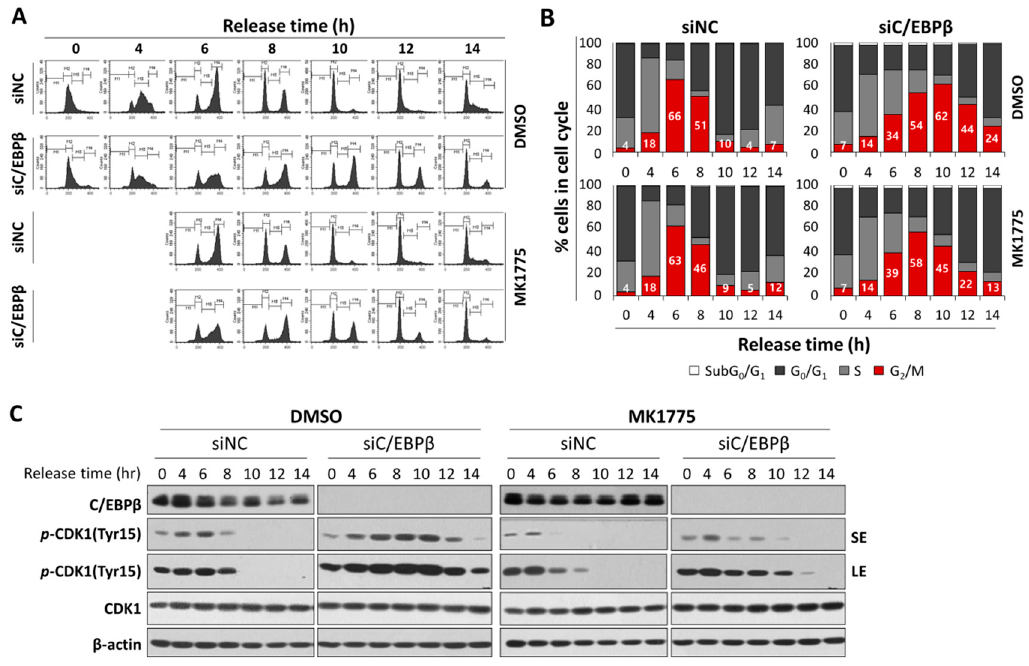
Figure 6. C/EBP β knockdown cells treated with MK1775 recovered from the delay in the G 2 /M phase. ( A , B ) A549 cells transfected with siNC or siC/EBP β were treated with either DMSO or MK1775 4 h after being released from thymidine double block. Cells were harvested for cell cycle analysis at different time points after release, and DNA contents with PI staining were analyzed using FACS. ( C ) Expression of cell cycle-associated proteins was analyzed in DMSO- or MK1775-treated control cells and C/EBP β -knockdown cells. Percentage of cells in each cell cycle phase is shown as a bar graph. SE; short exposure, LE; long exposure.